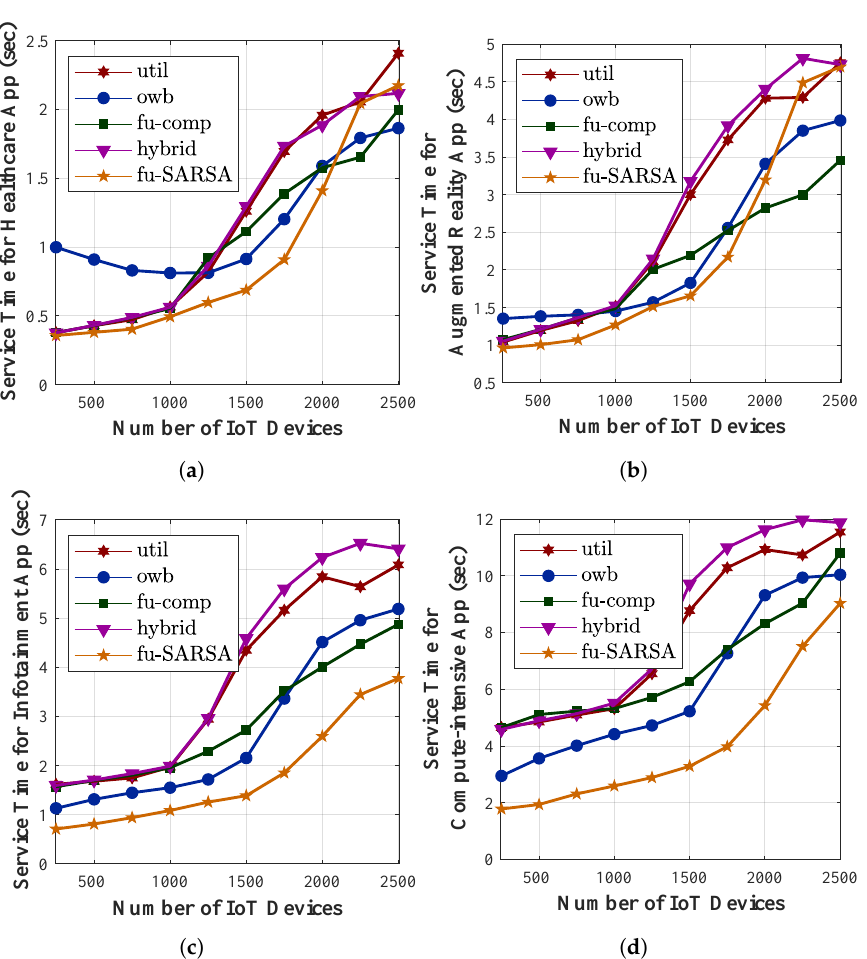
Figure 11. Comparison of service time with different application types: ( a ) Healthcare application. ( b ) AR application. ( c ) Infotainment application. ( d ) Compute-intensive application.